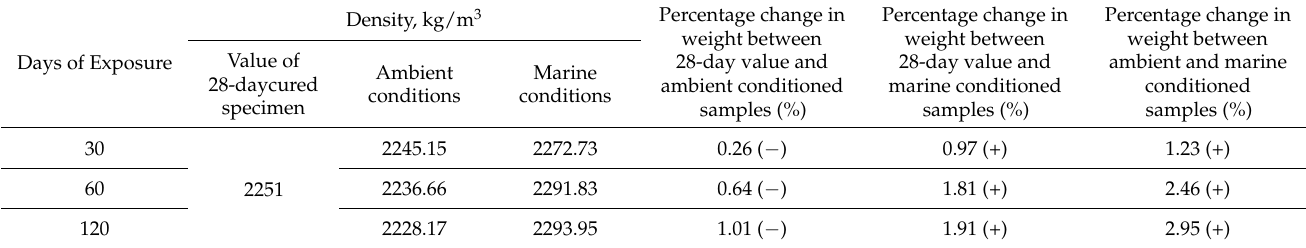
Table 5. Comparison of density changes under ambient and marine exposure conditions.